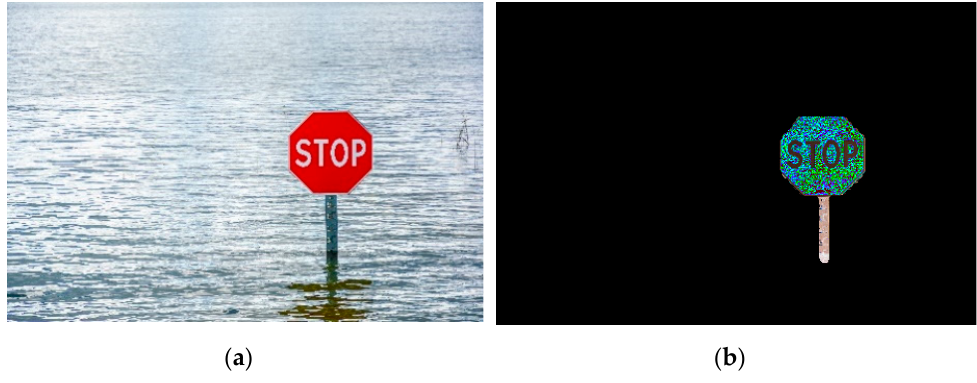
Figure 7. Illustration of the regular scenario: ( a ) the input image; ( b ) the output image.